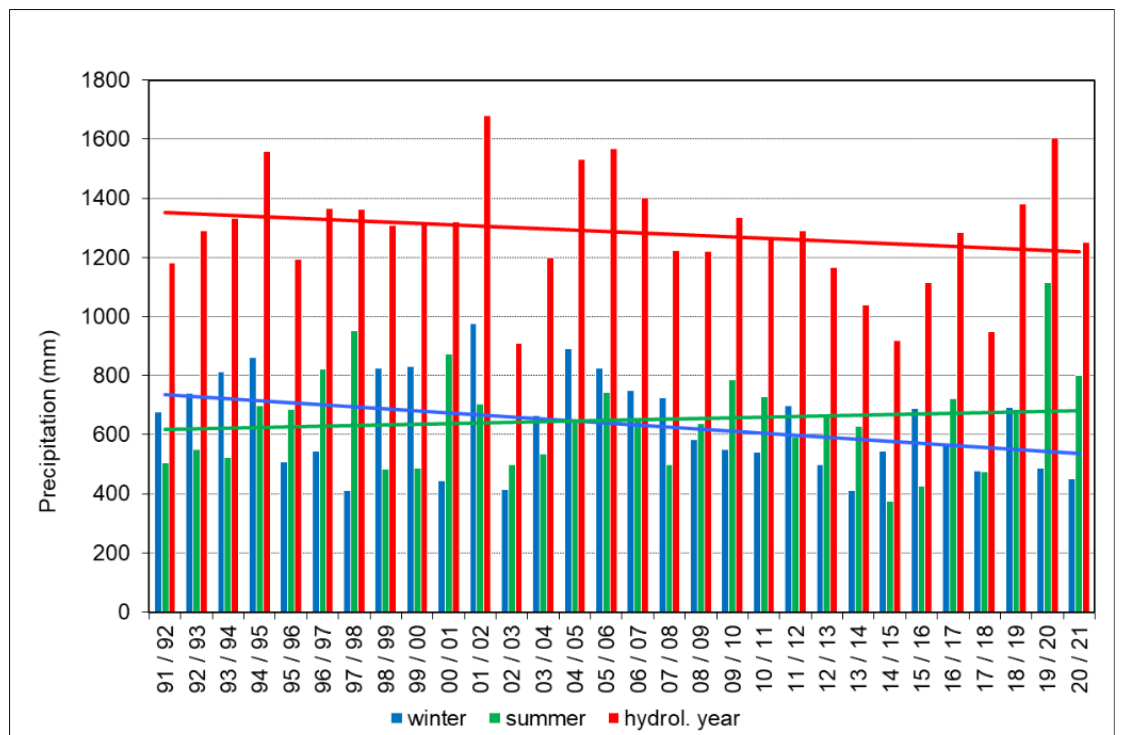
Figure 6. Precipitation trend on the experimental catchment UDL with linear regressions. Regression slope p: winter p = 0.04, summer p = 0.5, hydrol. year p = 0.3.